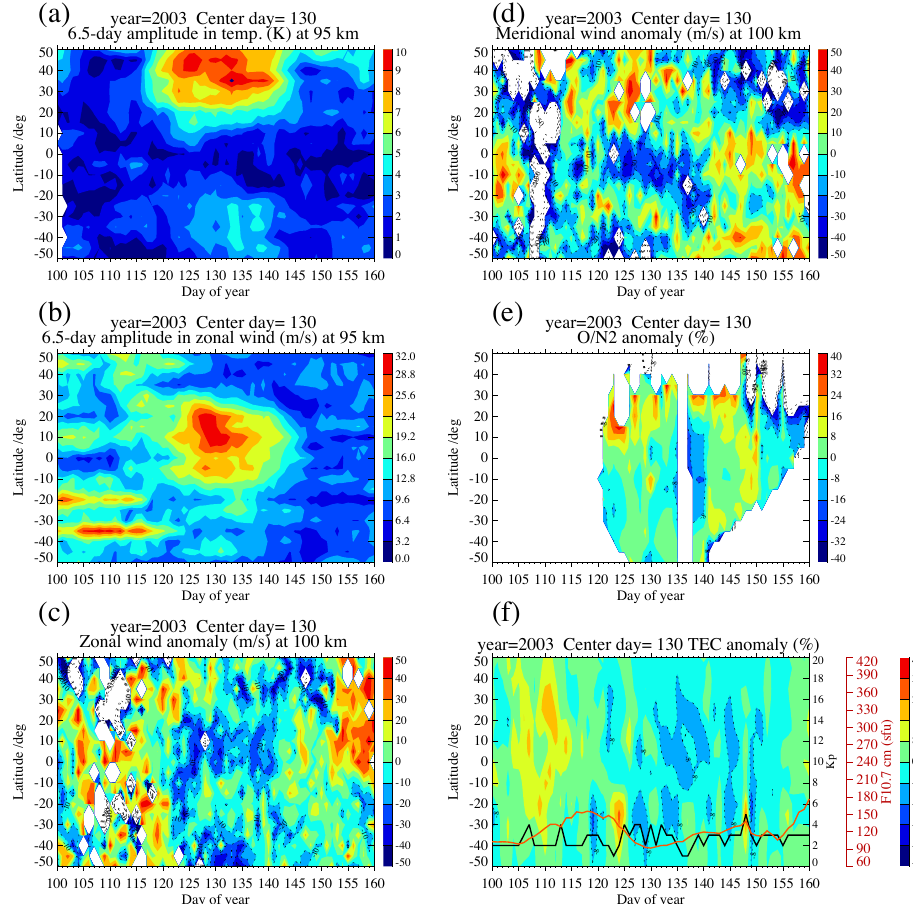
Figure 3. Daily variation of the 6.5-day wave amplitude in (a) SABER temperature and (b) TIDI zonal wind at 95km. (c) is the daily zonal wind anomaly at 100km. Positive (negative) denotes eastward (westward). (d) is the same as (c) , but for the meridional wind anomaly. Positive (negative) denotes northward (southward). (e) and (f) are percentage changes of the daily O / N 2 and TEC anomalies, respectively. All the plots are between day 100 and 160 in 2003 ranging from 50 ◦ S to 50 ◦ N. The contour intervals for (a) to (f) are 1K, 3.2ms − 1 , 10ms − 1 , 10ms − 1 , 8% and 8%, respectively. The red and black lines in panel (f) denote F 10 . 7cm and K p indices, respectively. The white region denotes no available